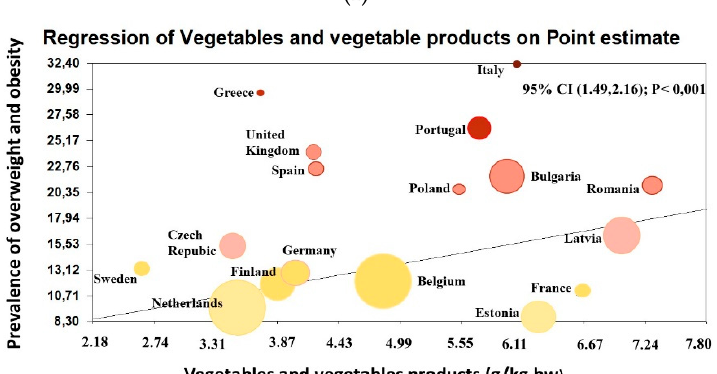
Figure 4. Meta-regression analyses. Plots show the point estimates of the prevalence of overweight/obesity of different countries in Europe during the period (2006–2016) according to different food groups provided by the food consumption data from the European Food Safety Authority (EFSA) (mean quantity in g/kg of body weight). Abbreviations: bw: body weight; g/kg: grams per kilogram; CI: confidence intervals.